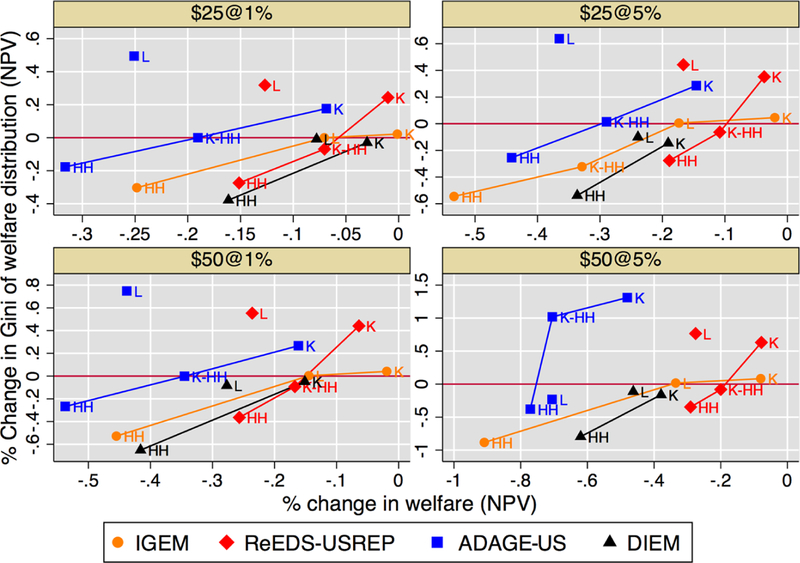
The trade-off between progressivity and aggregate welfare costs,
with progressivity measured by the tax-driven change in the Gini
coefficient of the welfare distribution. Note that axis scales differ
across panels.